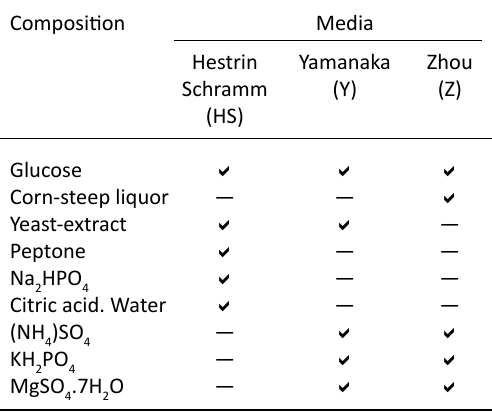
Table 1. Different types of culture media and their